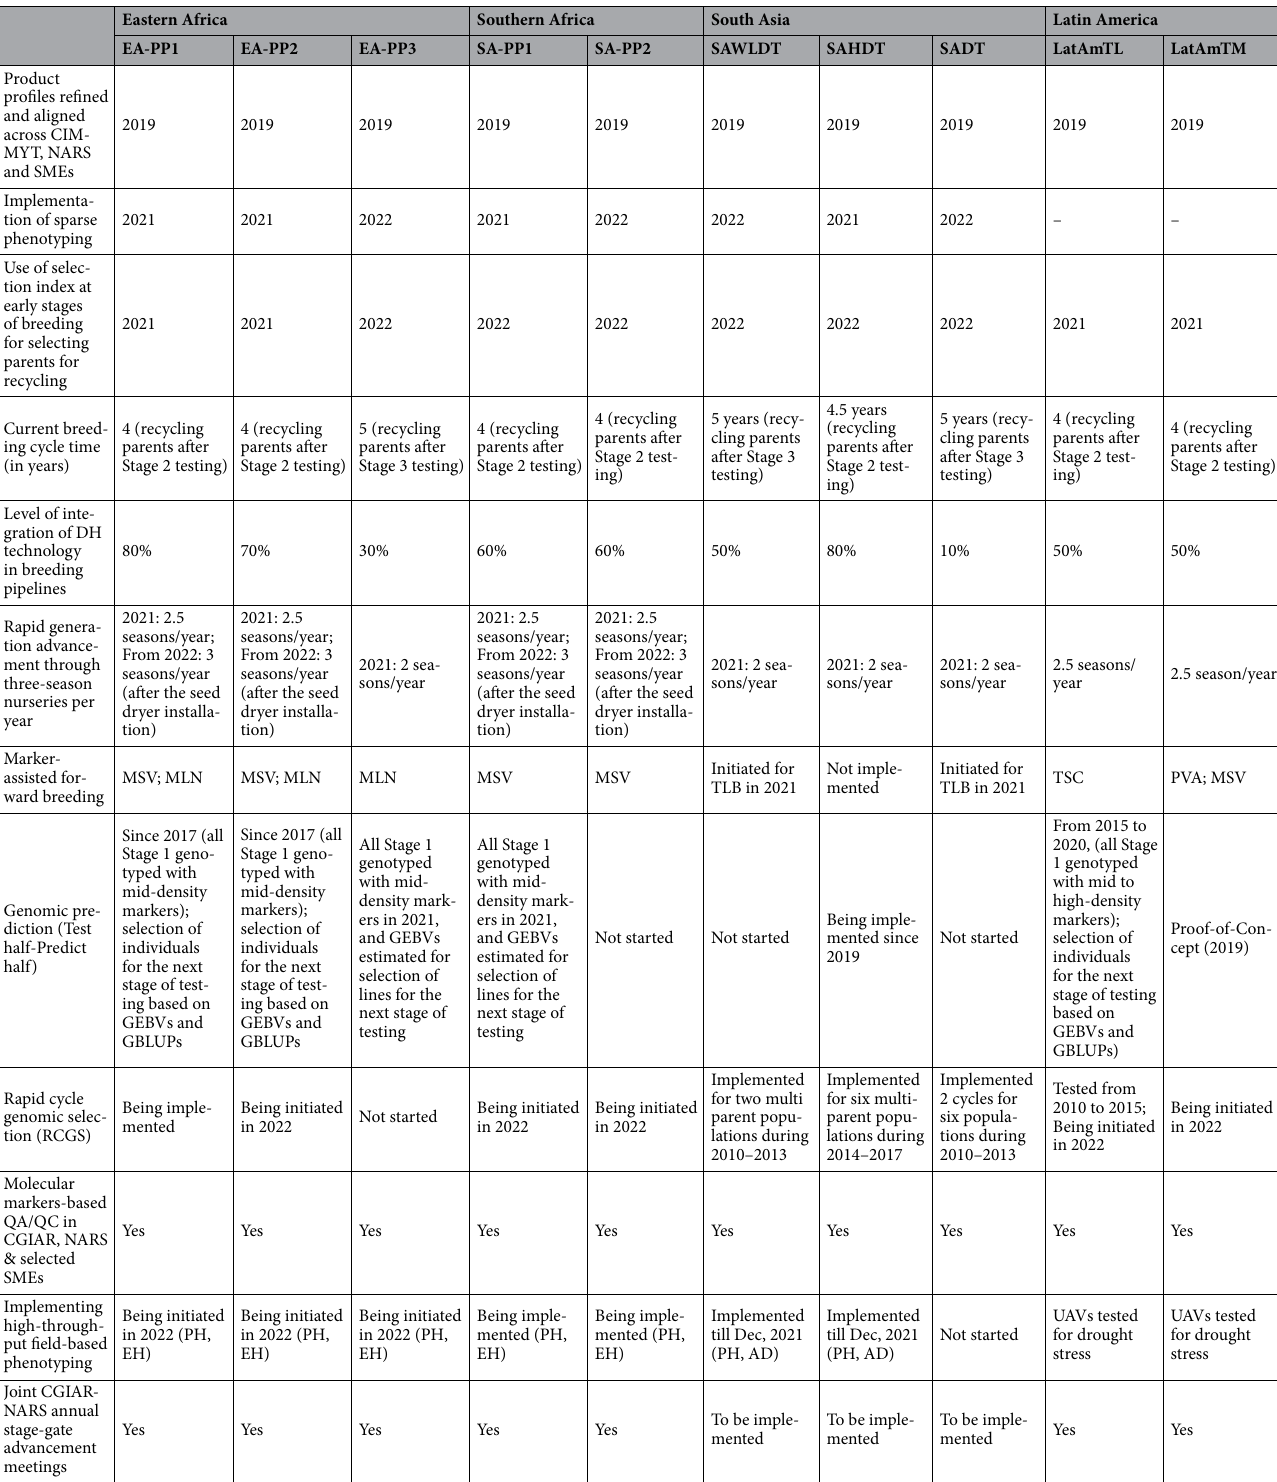
Table 1. Implementation of key breeding tools/processes to improve genetic gains in CIMMYT’s tropical maize breeding pipelines. Abbreviations: AD, Anthesis date; DH, Doubled haploid; EH, Ear height; GBLUP, Genomic best linear unbiased prediction; GEBV, Genomic estimated breeding value; MLN, Maize Lethal Necrosis; MSV, Maize Streak Virus, PH, Plant height; PVA, Provitamin A; TLB, Turcicum Leaf Blight; TSC, Tar Spot Complex; UAV, Unmanned aerial